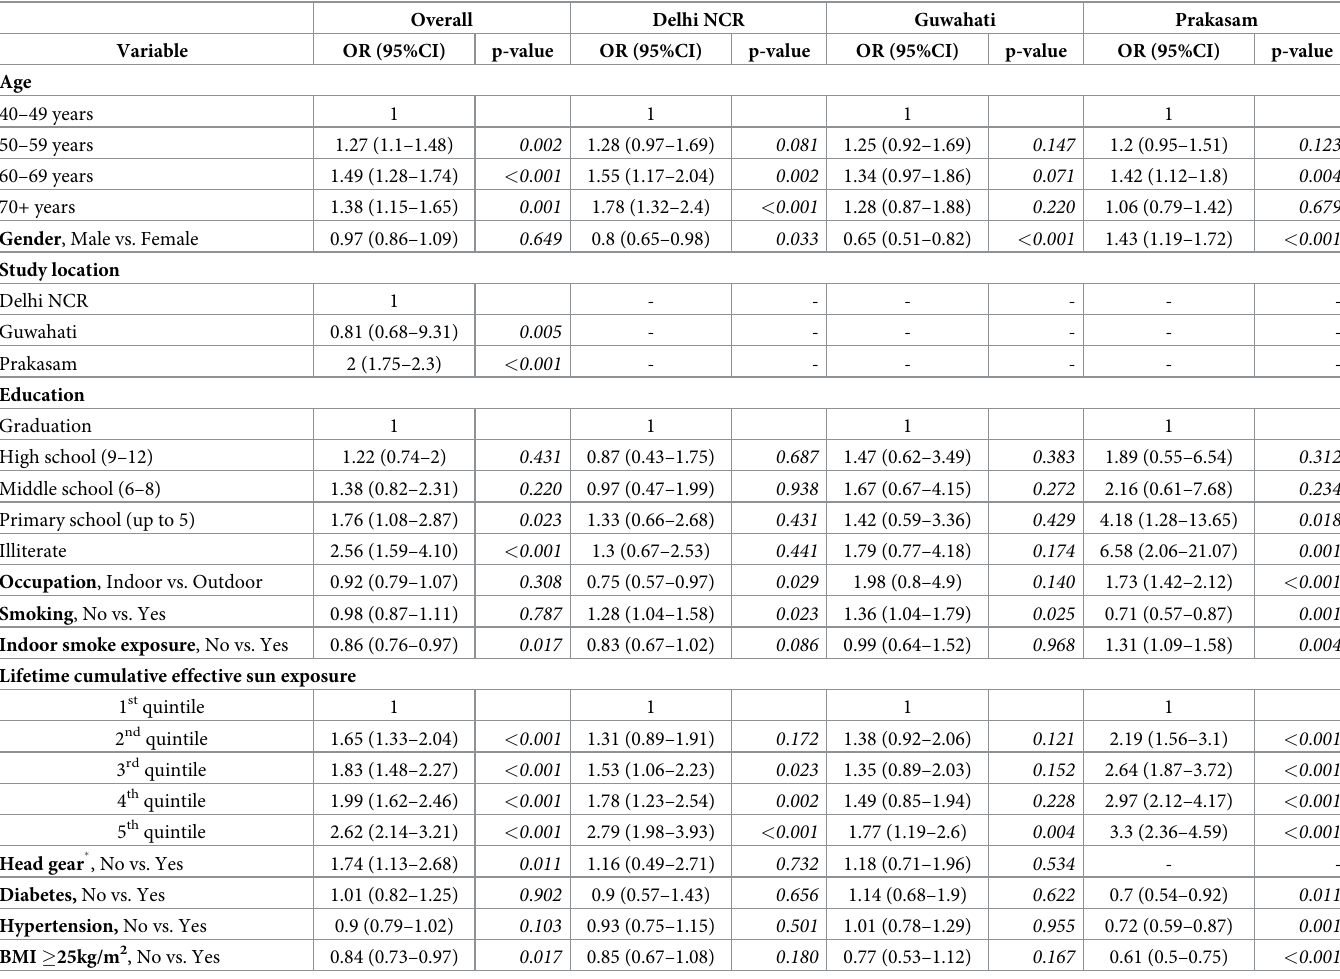
Table 2. Association of pterygium with sociodemographic and systemic